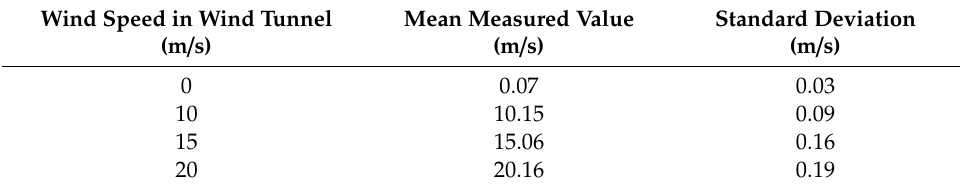
Figure 10. Tests with different wind speeds: ( a ) 0, ( b ) 10, ( c ) 15, and ( d ) 20 m/s. Table 1. Mean measured values and standard deviations at different wind speeds.